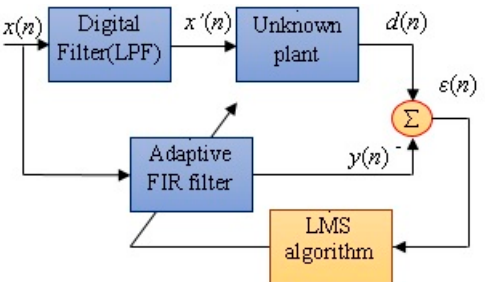
Figure 6. System identification configuration for the case of the colored input signal.